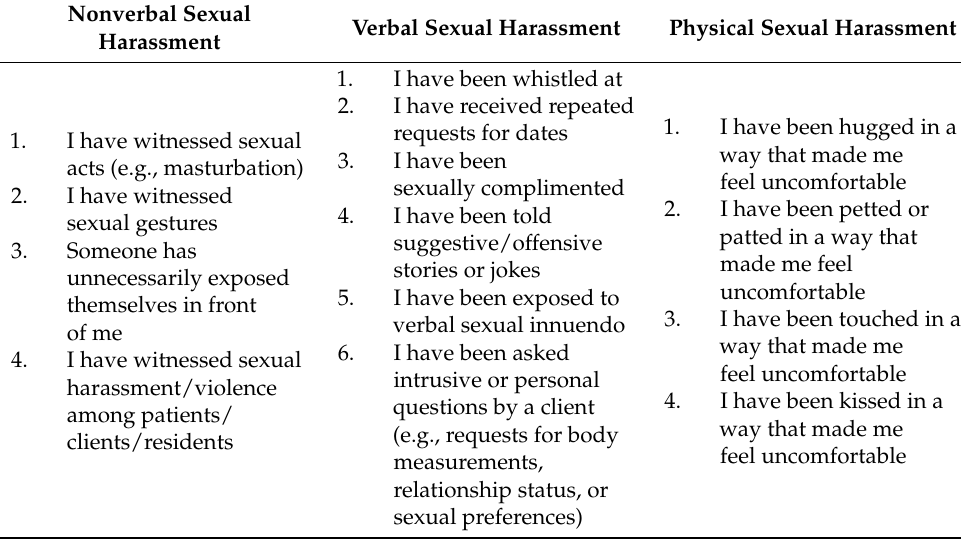
Table 2. Items of the Sexually Harassing Behavior Questionnaire (SHBQ-X